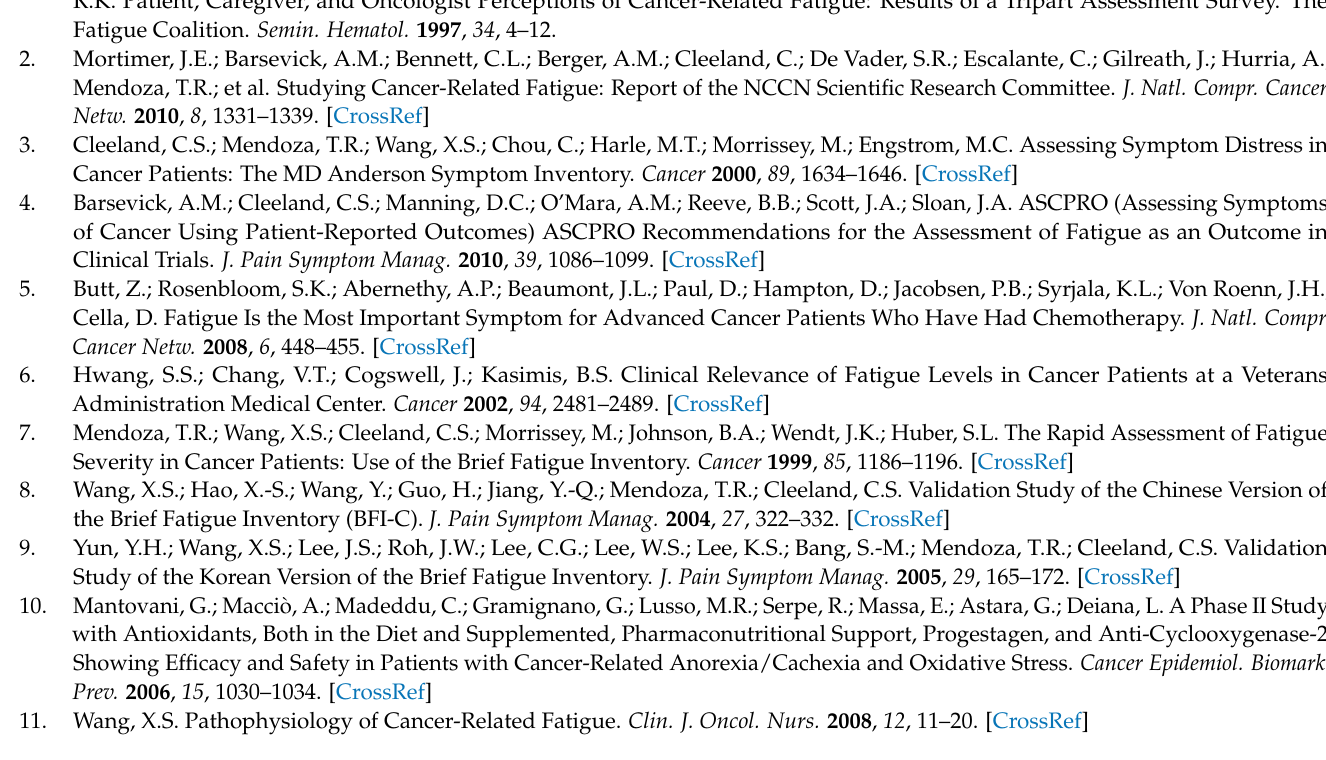
and Table S5: Welch’s t -test results comparing the percent change of serum amino acid and associated metabolite concentrations from baseline to post-treatment between placebo and testosterone